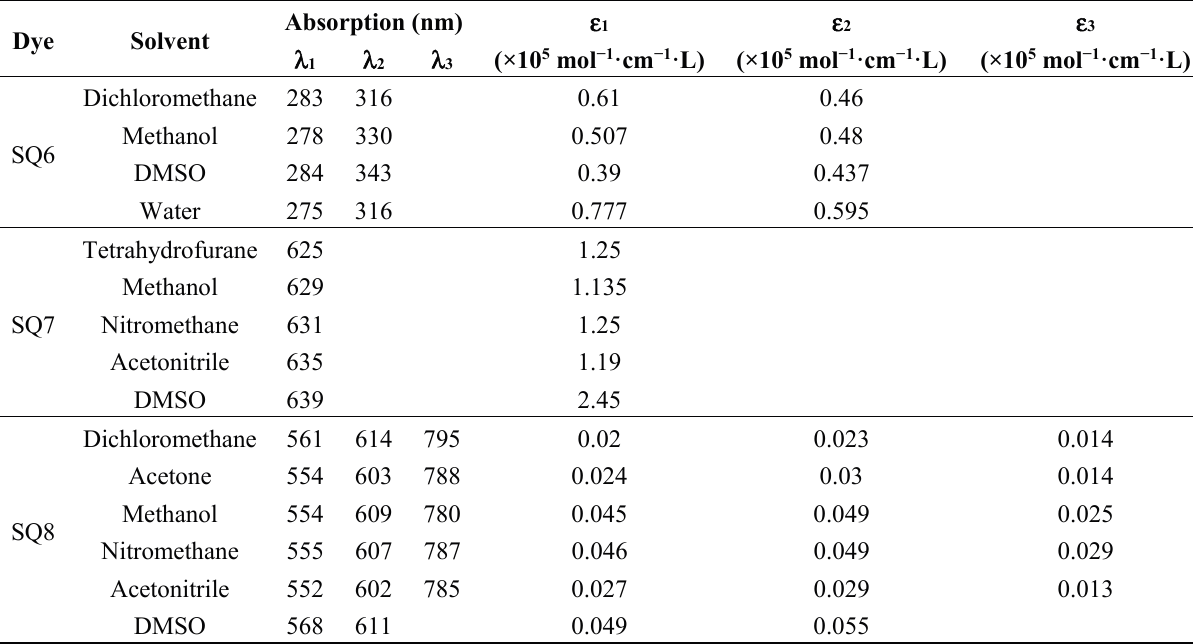
Table 1. Spectral data of dyes in different